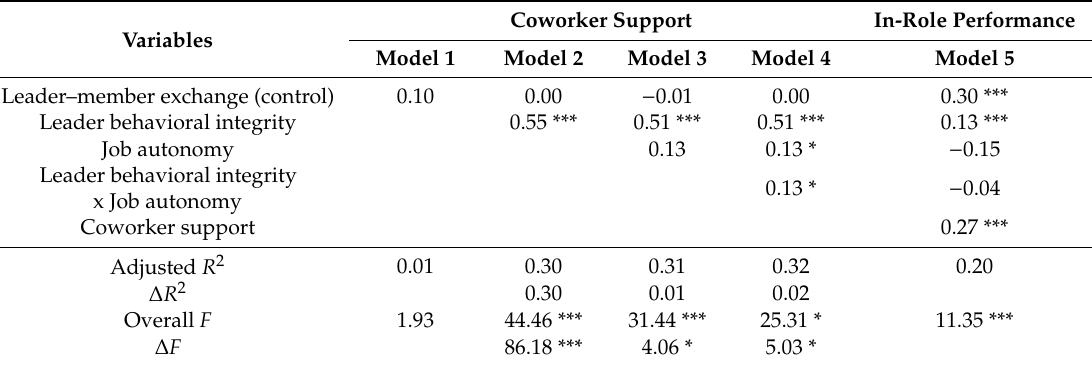
Table 2. Hierarchical regression